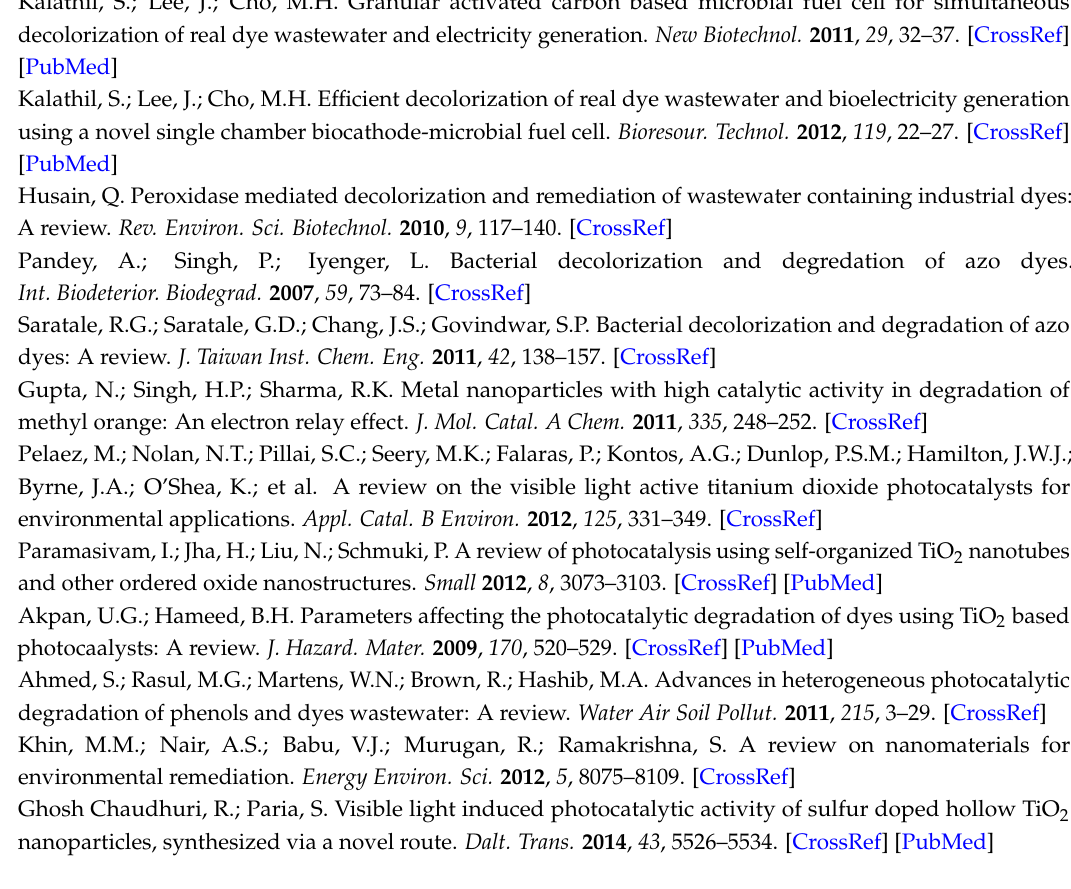
Figure S1: High resolution TEM images of solid Pd nanoparticles; Figure S2: High resolution TEM images of hollow Pd nanoparticles; Figure S3: Plot of percent removal of MO dye in the solution with time at different conditions (control experiments); Scheme S1: Schematic of Pd hollow nanoparticles formation through Kirkendall method using Co as sacrificial